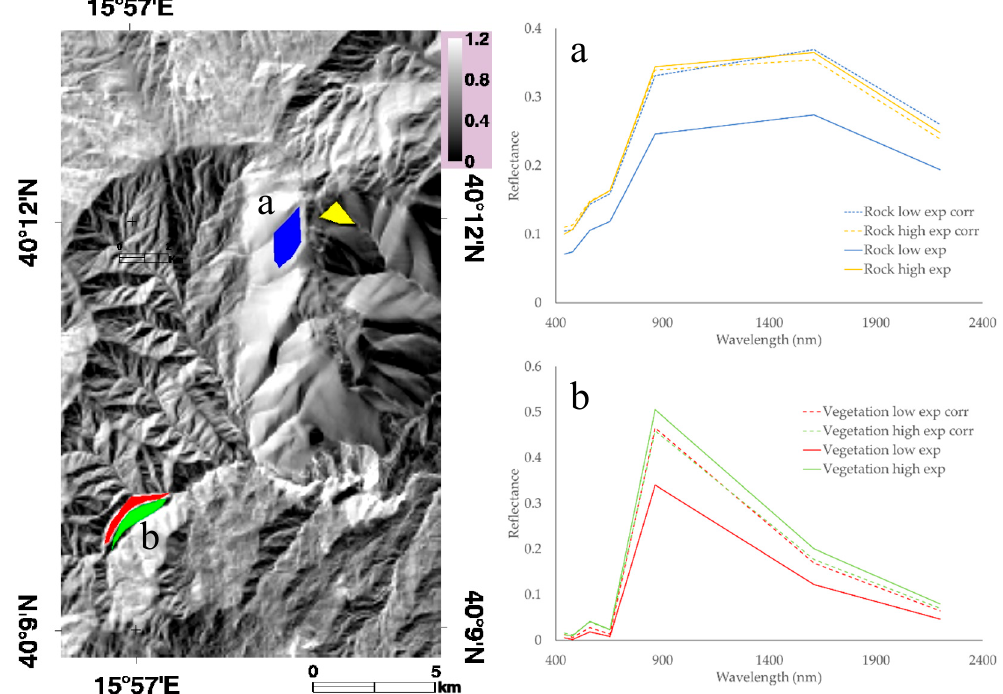
Figure 7. Location and mean spectra of the ROIs related to the rock ( a ) and vegetation ( b ) classes. The graphs show the mean spectra of the ROIs before (solid lines) and after (dashed lines) the inclusion of topographic corrections.